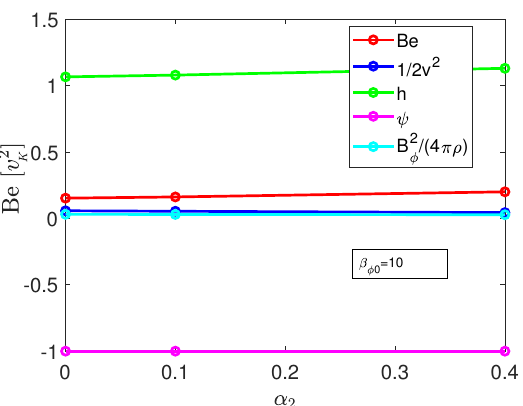
. Here the gas pressure is 10 times larger than the magnetic k